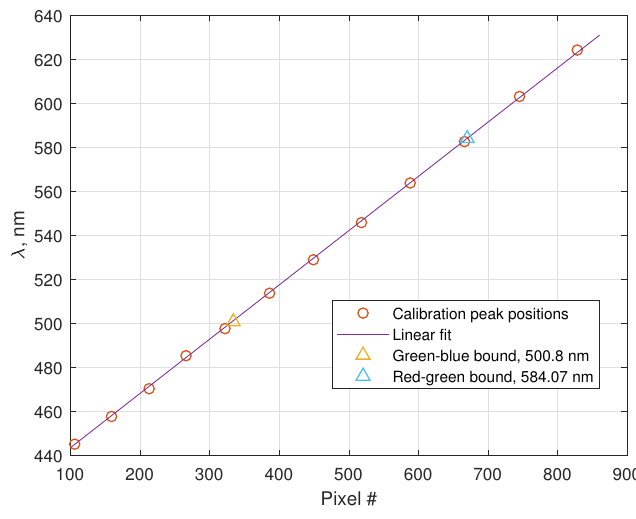
Figure 4. Wavelength calibration